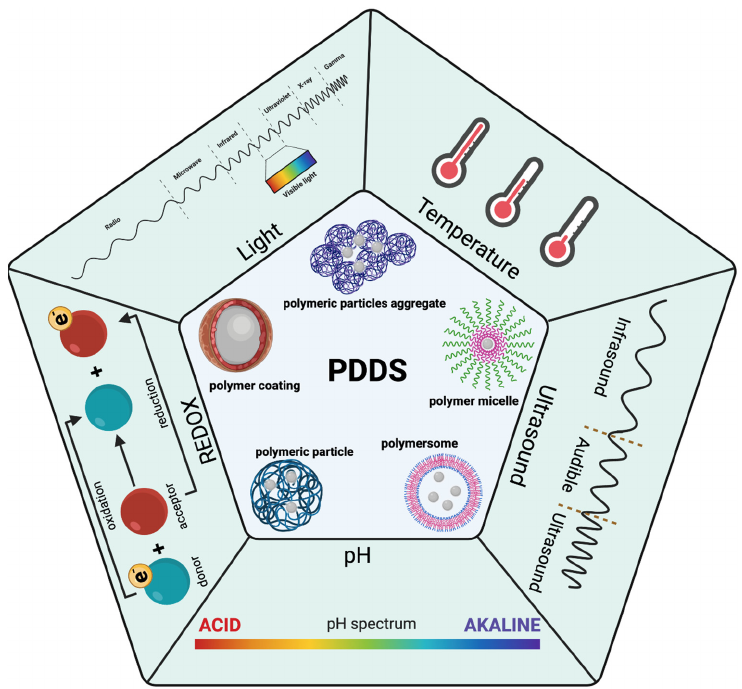
Figure 1. A schematic representation of stimuli that can trigger drug release using particle drug delivery systems (PDDS) based on polymers. Created in Biorender.com, accessed date (2 September 2022).